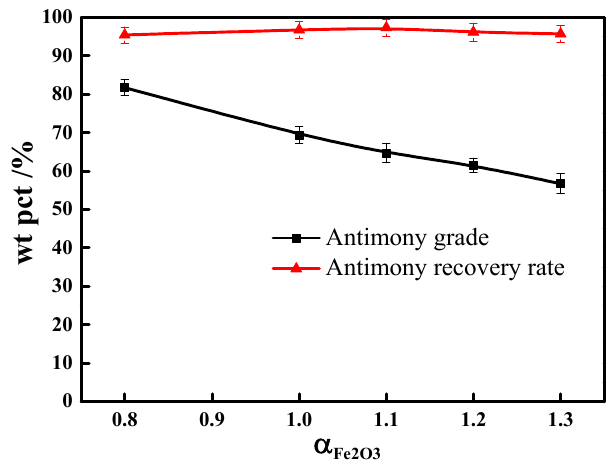
Figure 6. Influence of ferric oxide dosage on the extraction of antimony and antimony grade. ( α salt =